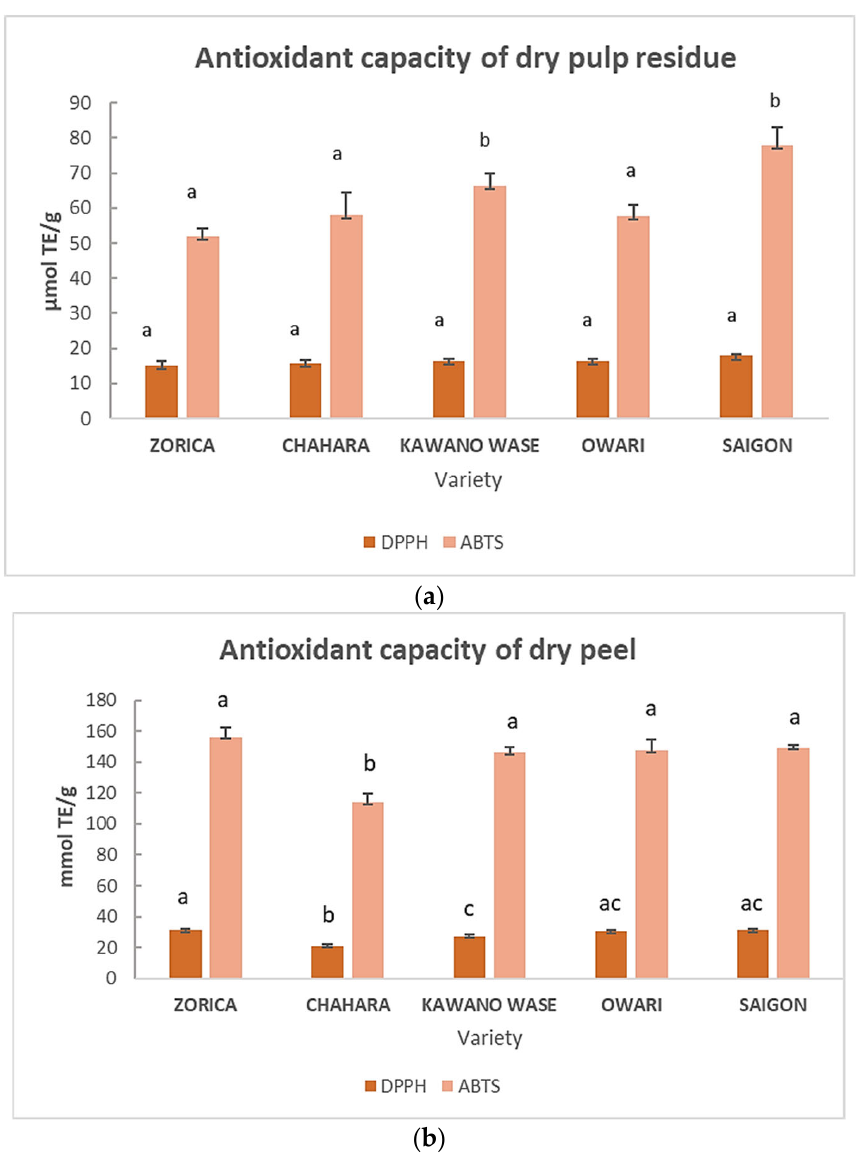
Figure 3. Antioxidant capacity in ( a ) dry pulp residue and ( b ) dry peel, as determined by two methods (DPPH and ABTS), in different varieties of mandarins from Neretva valley (Croatia). Results are expressed per g of dry weight mandarin pulp/peel. The same letters above the same-colored bars are not significantly different according to the post hoc t -test with Bonferroni adjustment ( p <